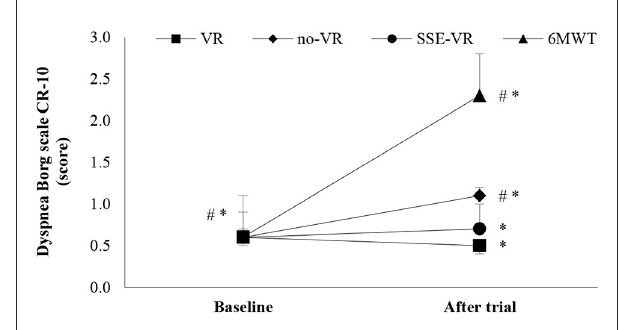
FIGURE5 Dyspnea changes between trials. * p < 0.001, # p < 0.05 [virtual reality (VR), exercise using the virtual reality system; no-VR, exercise without using the VR system; SSE-VR, self-selected exercise using the VR system; 6MWT, 6-min walk test].